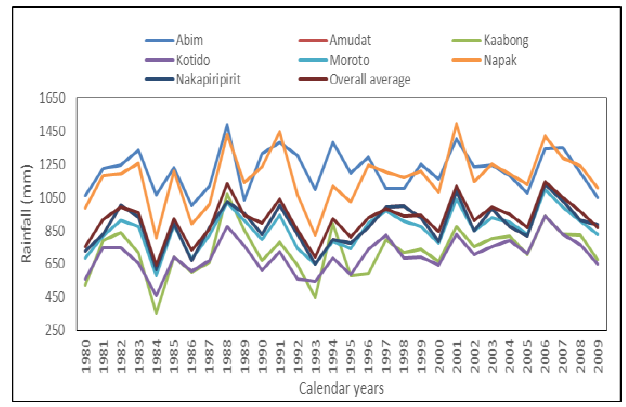
Figure 2. Historical rainfall trend for Karamoja sub-region.